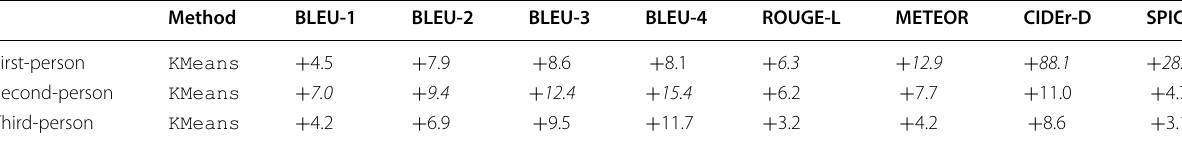
Highest values are in italic Table 2 The relative improvement rate (%) of triple input vs ablated double input. For example, the “First‑Person” scores are computed from and KMeans-123